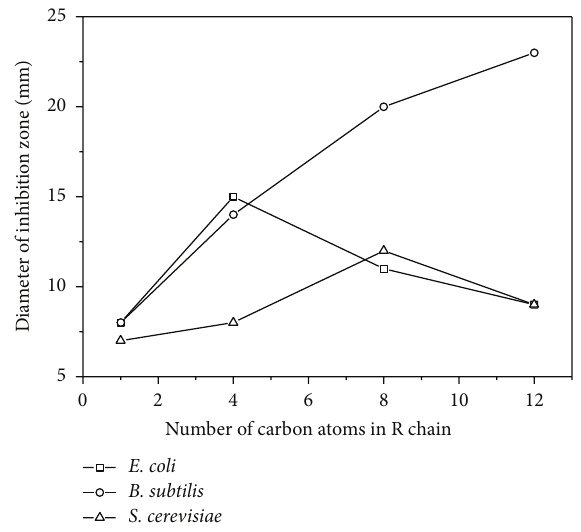
Figure 2: Antibacterial activity of ILs with fumarate anion. Dose: 0.6 mg for B. subtilis , 1.2mg for E. coli and S. cerevisiae